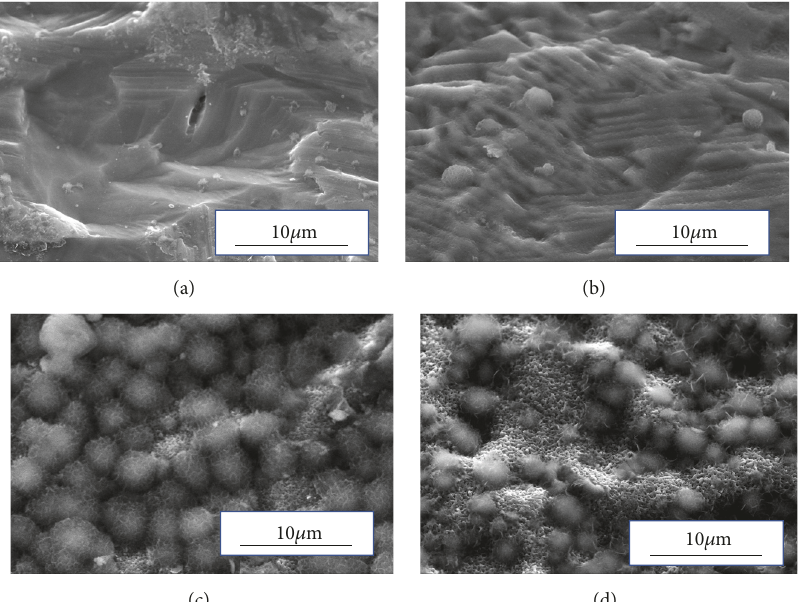
Figure 2: SEM photos of the surface of the samples after immersion in SBF for 1 day. (a) SBF-STD-Ti, (b) SBF-P-Ti, (c) SBF-S-Ti, and (d) SBF-Sp-Ti.